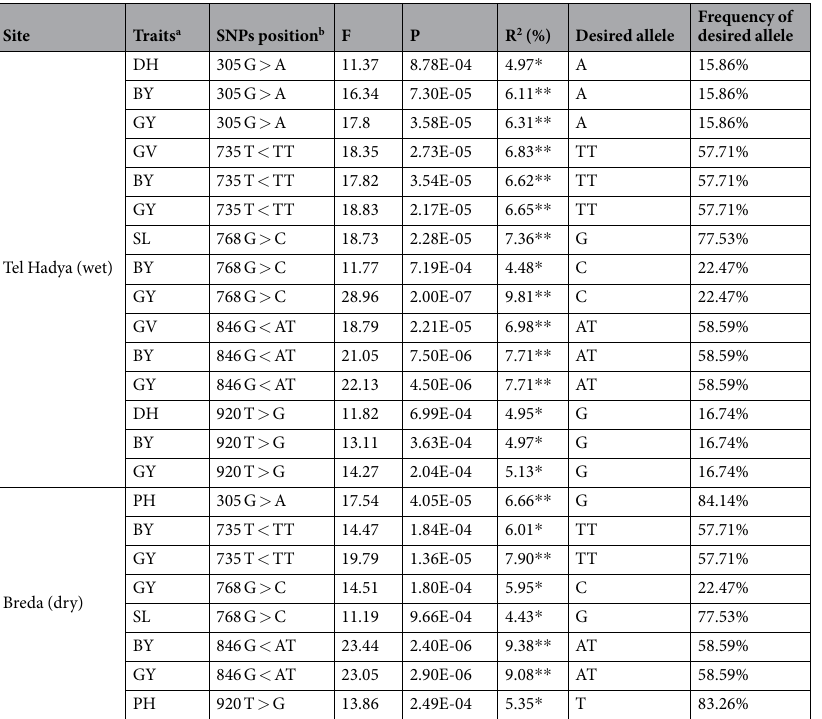
Table 3. Significant associations between SNPs of HvP5CS1 and agronomic traits of barley. a GV: growth vigour (1 = good; 5 = bad), DH: days to heading, PH: height at the base of the spike (cm), SL: spike length (cm), BY: total above ground biomass dry yield (kg/ha), GY: grain yield (kg/ha). b The number of SNP positions is relative to the sequence on PCR amplicon of reference DNA (ICARDA IG: 138264). R 2 is the fraction of the total variation explained by the marker. * Indicates SNP significantly (P < 0.001) associated with traits. ** Indicates SNP highly significantly (P < 0.0001) associated with traits.